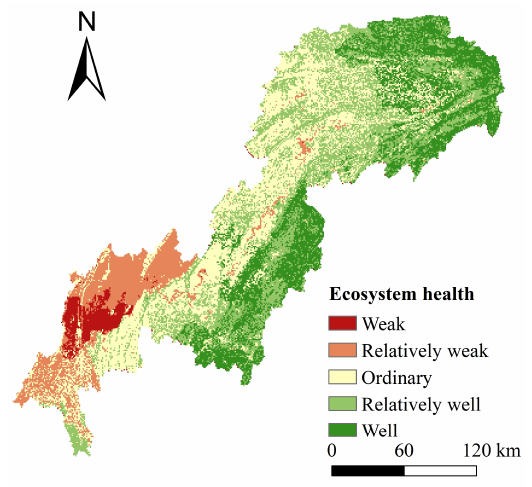
Figure 5. Spatial distribution of ecosystem health evaluation.